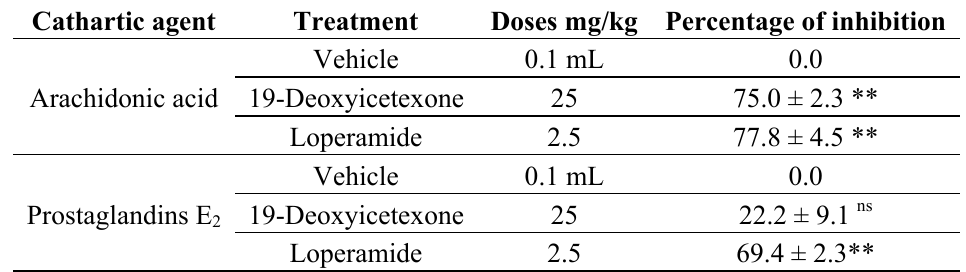
-induced diarrhea. 2